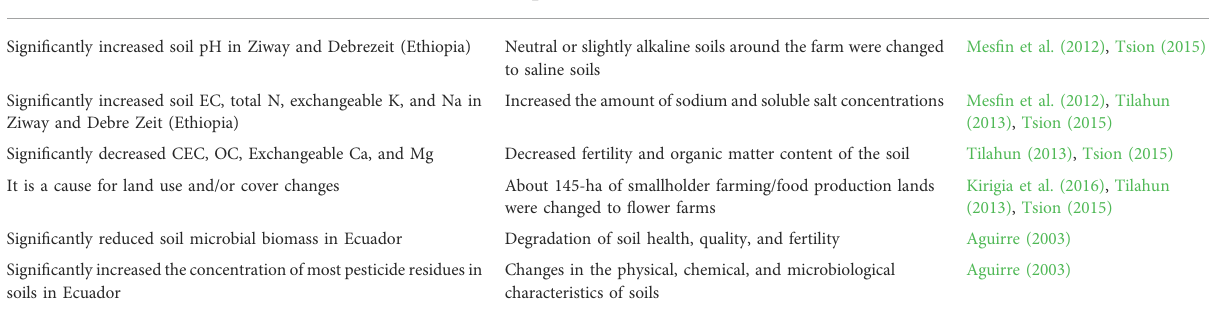
TABLE 2 Impacts of fl oriculture on soil physical and chemical